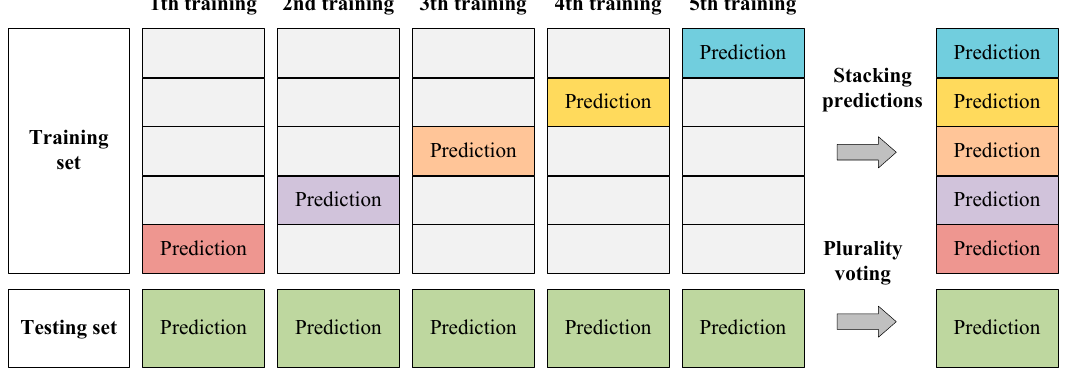
Figure 5. Generating process of training and testing data for ensemble learning in each network. The training and testing data for ensemble learning are composed of pixel classifica- tions for predictions from single semantic segmentation networks. For the training and testing data, their true classes as labels are extracted from the built image database. The composition of the generated training and testing data for ensemble learning are presented in Figure 6. The classifications of all pixels in prediction images of semantic segmentation network base models and their labels are applied as training data. The pixel classifications from plurality voting for the testing images are used as the testing data.